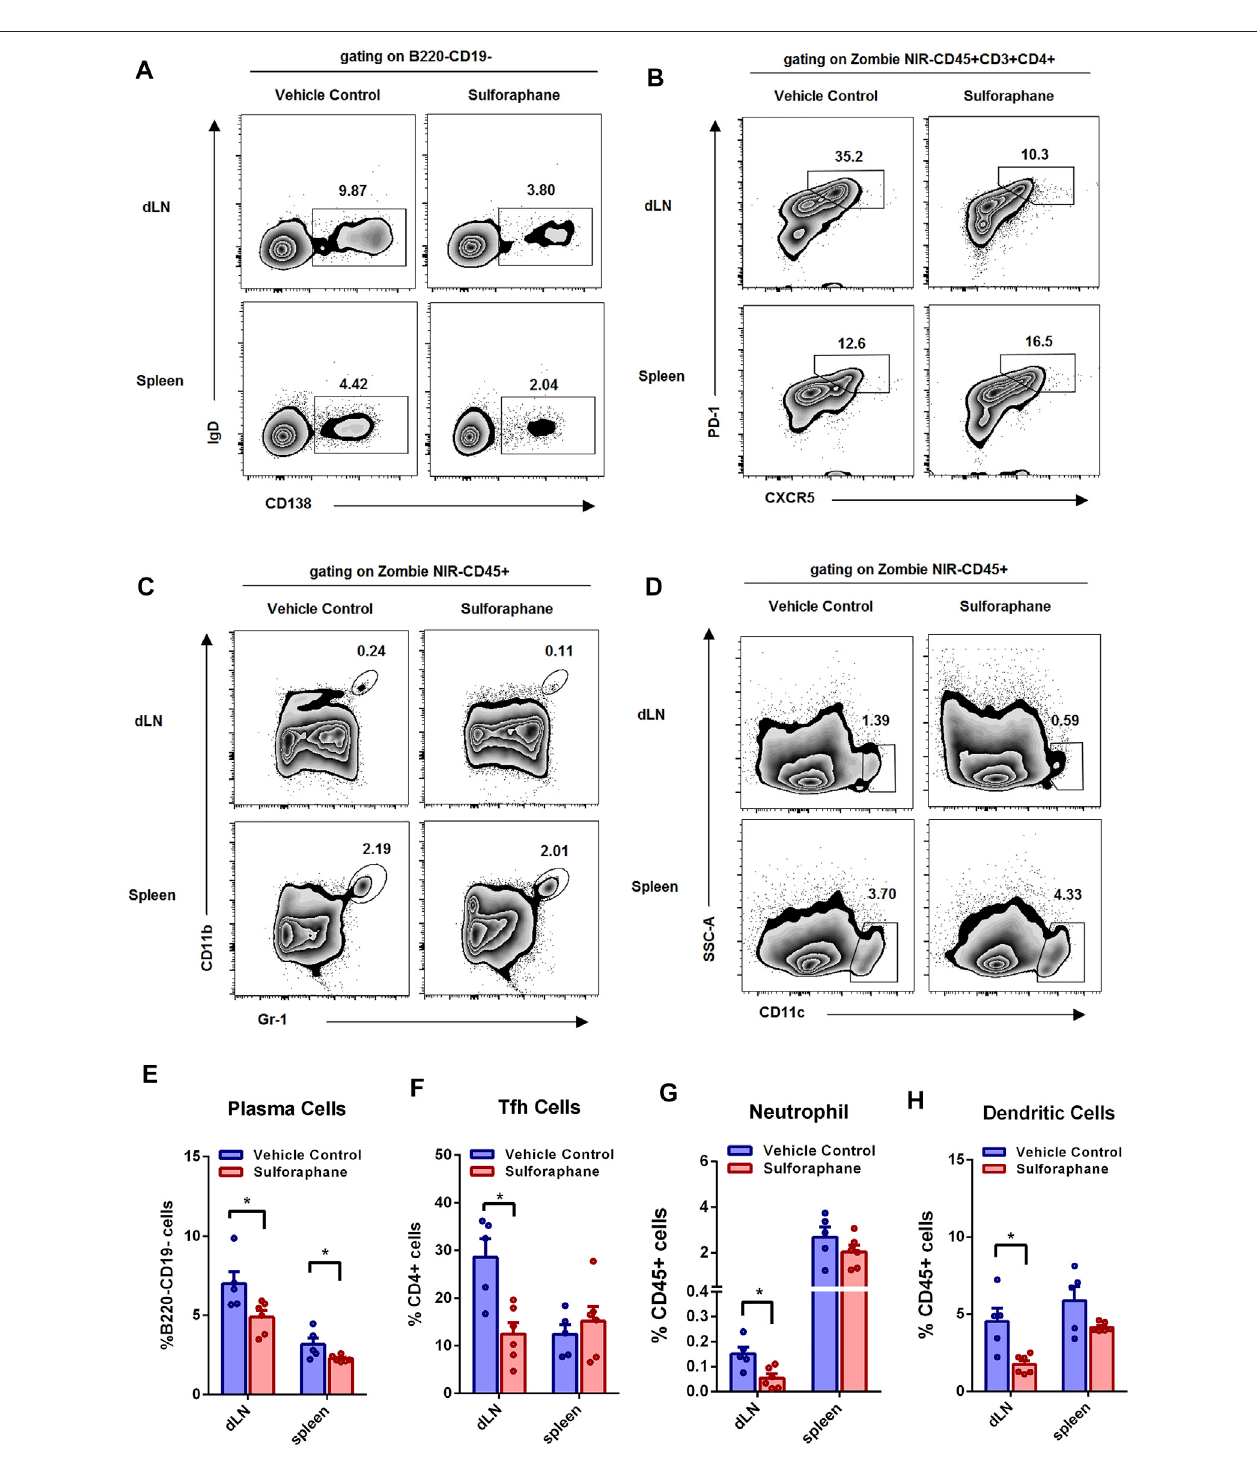
FIGURE 4 | Sulforaphane reduced the percentages of plasma cells, Tfh cells, neutrophils, and dendritic cells in lupus-prone MRL/lpr mice (n (cid:1) 6). (A – D) Representative fl ow cytometric analysis of plasma cells (A) , Tfh cells (B) , neutrophils (C) and dendritic cells (D) in the dLNs and spleens from MRL/lpr mice treated with sulforaphane or vehicle control. (E – H) Statistical analysis of (A – D) . The data represent the mean ± SEM. * p < 0.05.